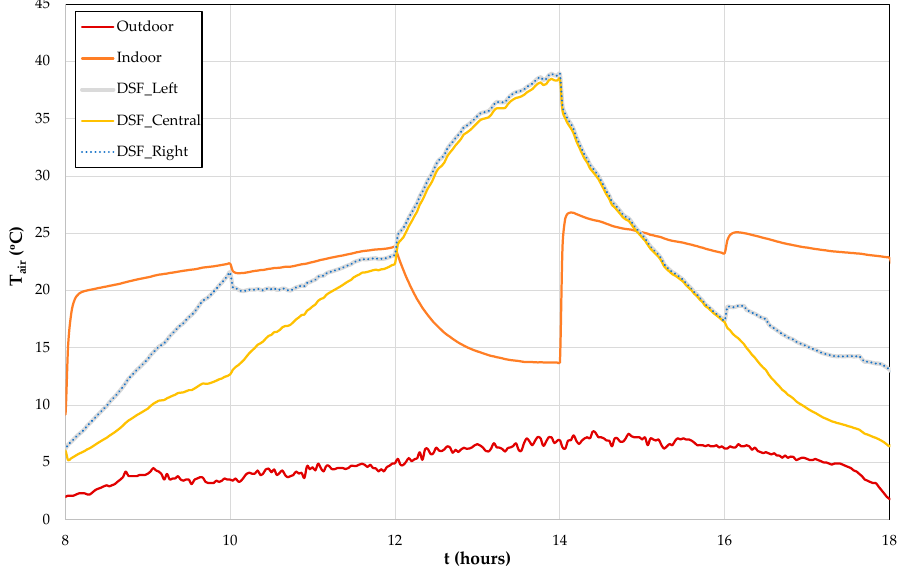
Figure 21. Evaluation of air temperature (T air ) of the outdoor environment, indoor virtual chamber and indoor left, central and right DSF system, when the airflow rate is variable and the number of DSFs to operate is variable, for the Case I.